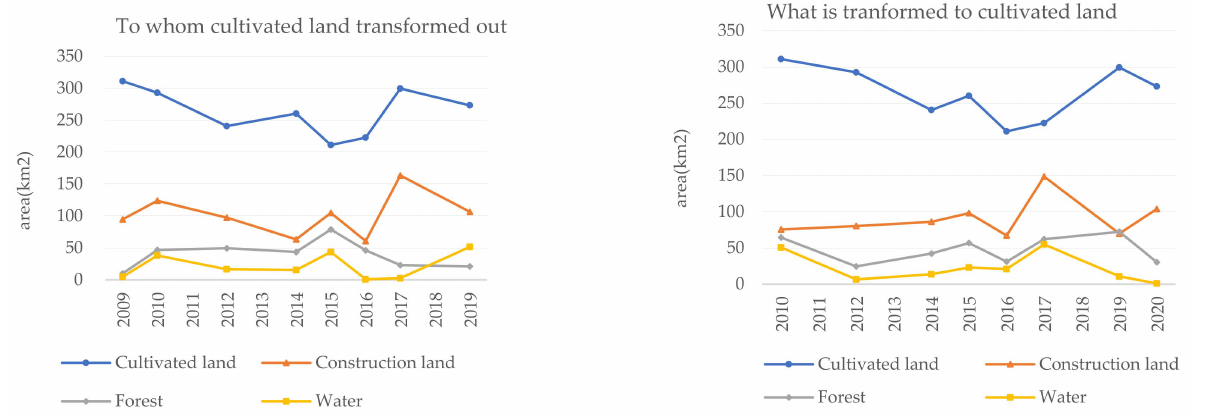
Figure 12. Changes of cultivated land in the studied